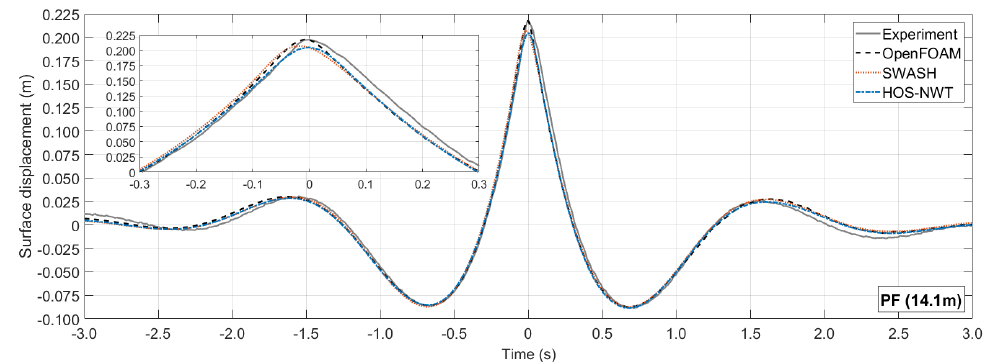
Figure 13. Comparison of the free surface elevation between the numerical models and the experi- ment at the PF